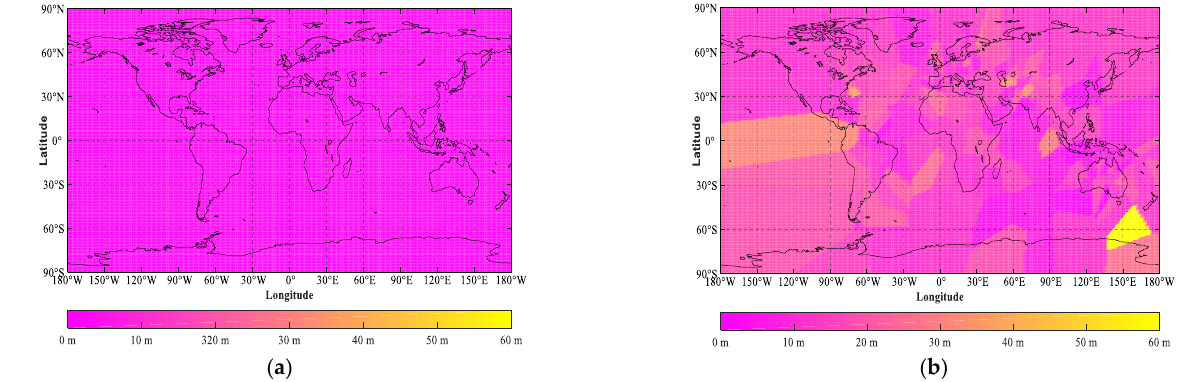
Figure 7. Global threshold distribution of IICODM based on ( a ) GPS and ( b ) BDS observation under case1 and case2.